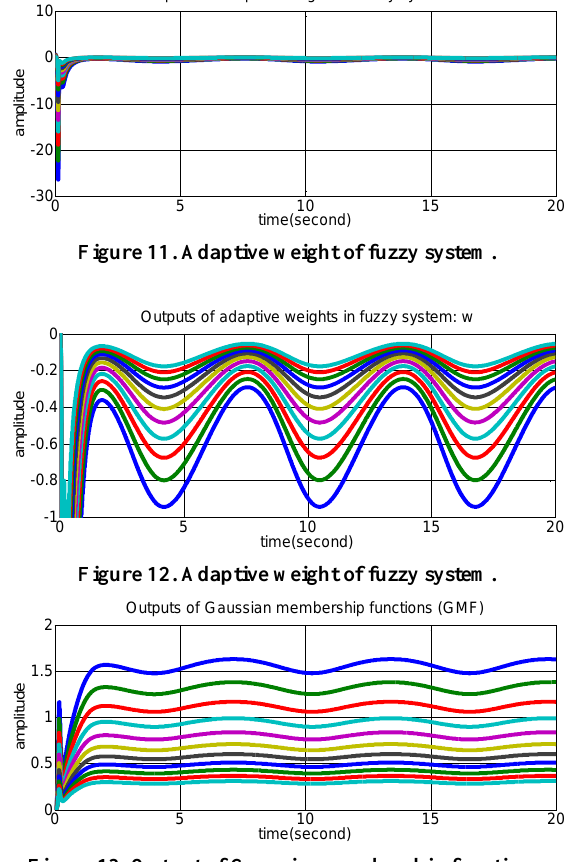
Figure 13. Output of Gaussian membership functions.